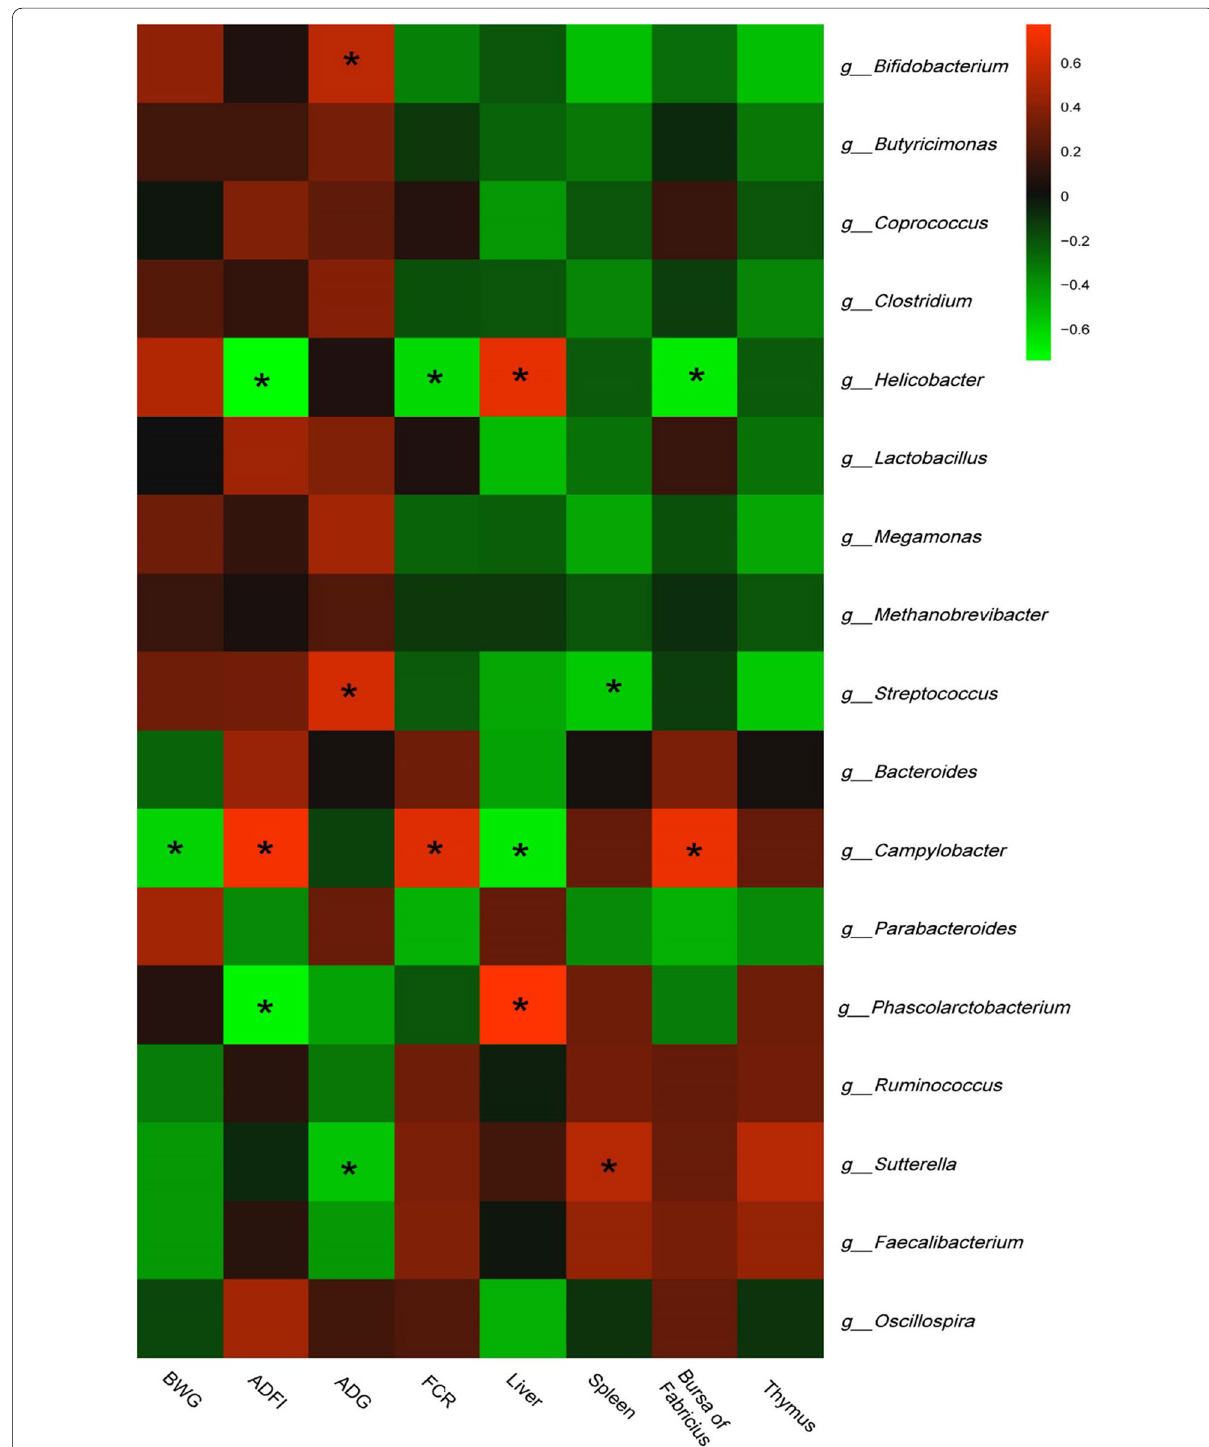
Fig. 3 Correlation analyses between relative abundances of cecal bacteria and growth performances, and immune organs at the level of genera. The red color represents positive correlation while the green color represents a negative correlation. *A significant correlation (|r| > 0.55, P <